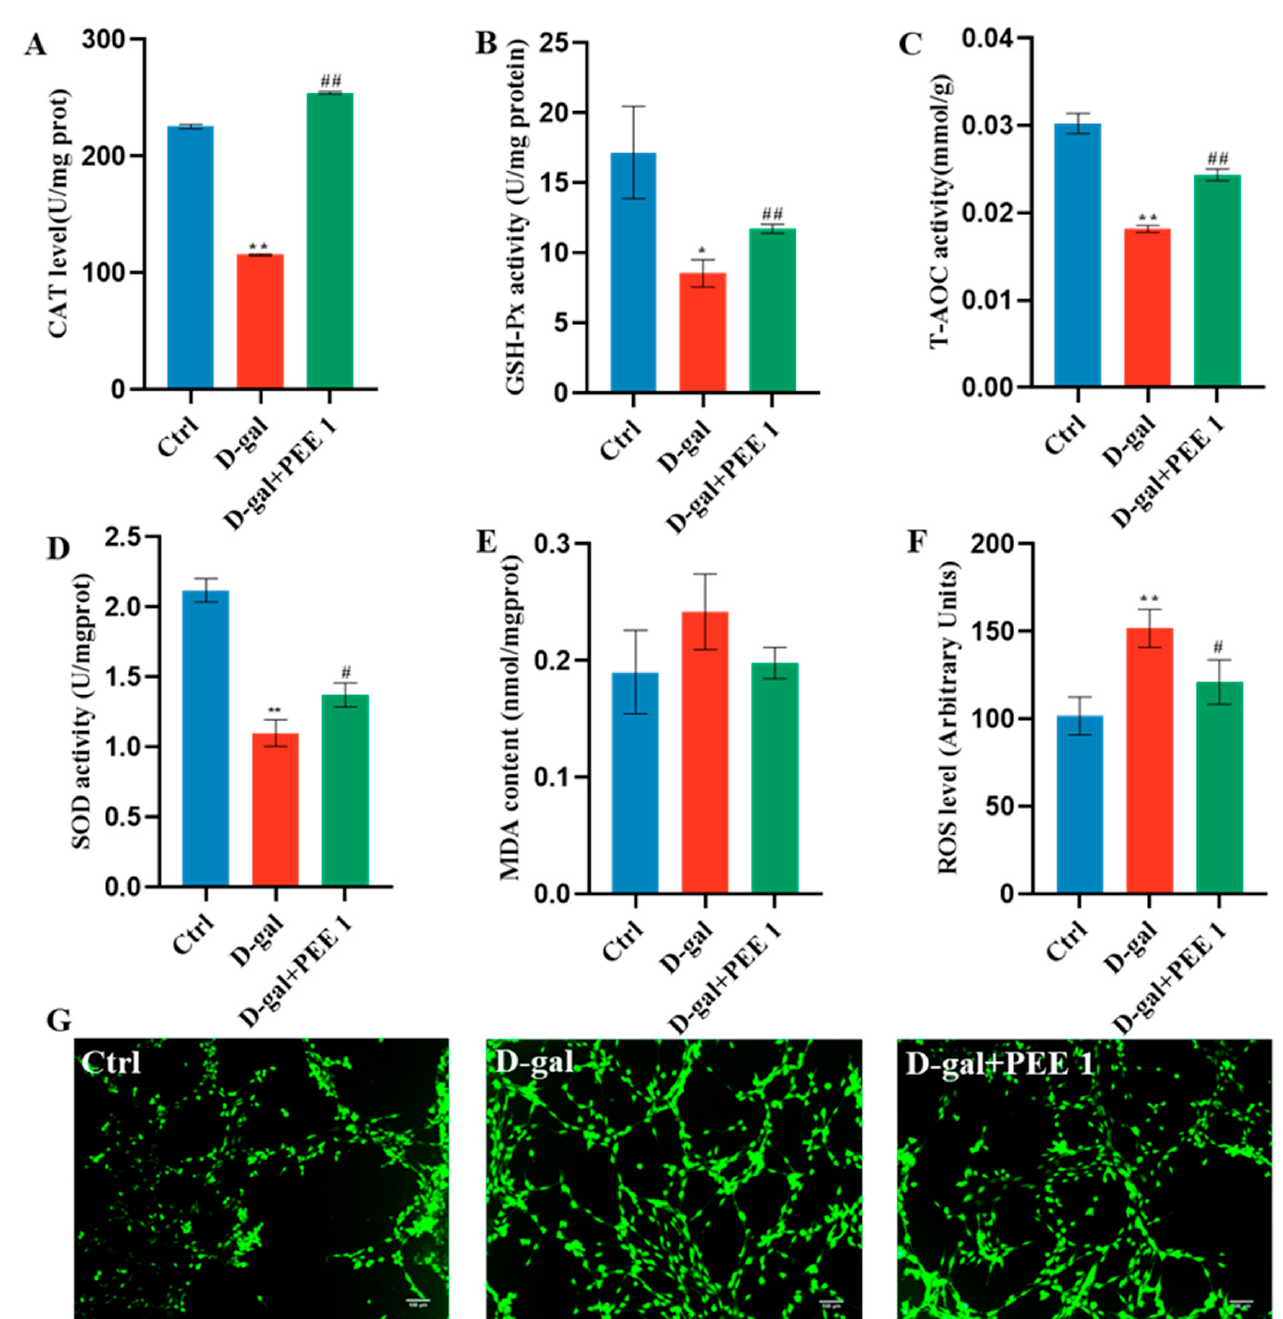
Figure 3. PEE attenuated ROS production and improved redox homeostasis in D-gal-treated C2C12 cells. Levels of CAT ( A ), GSH-Px ( B ), T-AOC activity ( C ), SOD ( D ), MDA ( E ) and ROS ( F ) in C2C12 cells. ( G ) Representative images of intracellular ROS in C2C12 cells stained with DCFH-DA after PEE treatment (scale bar = 100 µm). All data are expressed as mean ± SEM (n = 3). * p < 0.05 and ** p < 0.01 vs. Ctrl; # p < 0.05 and ## p < 0.01 vs. D-gal.